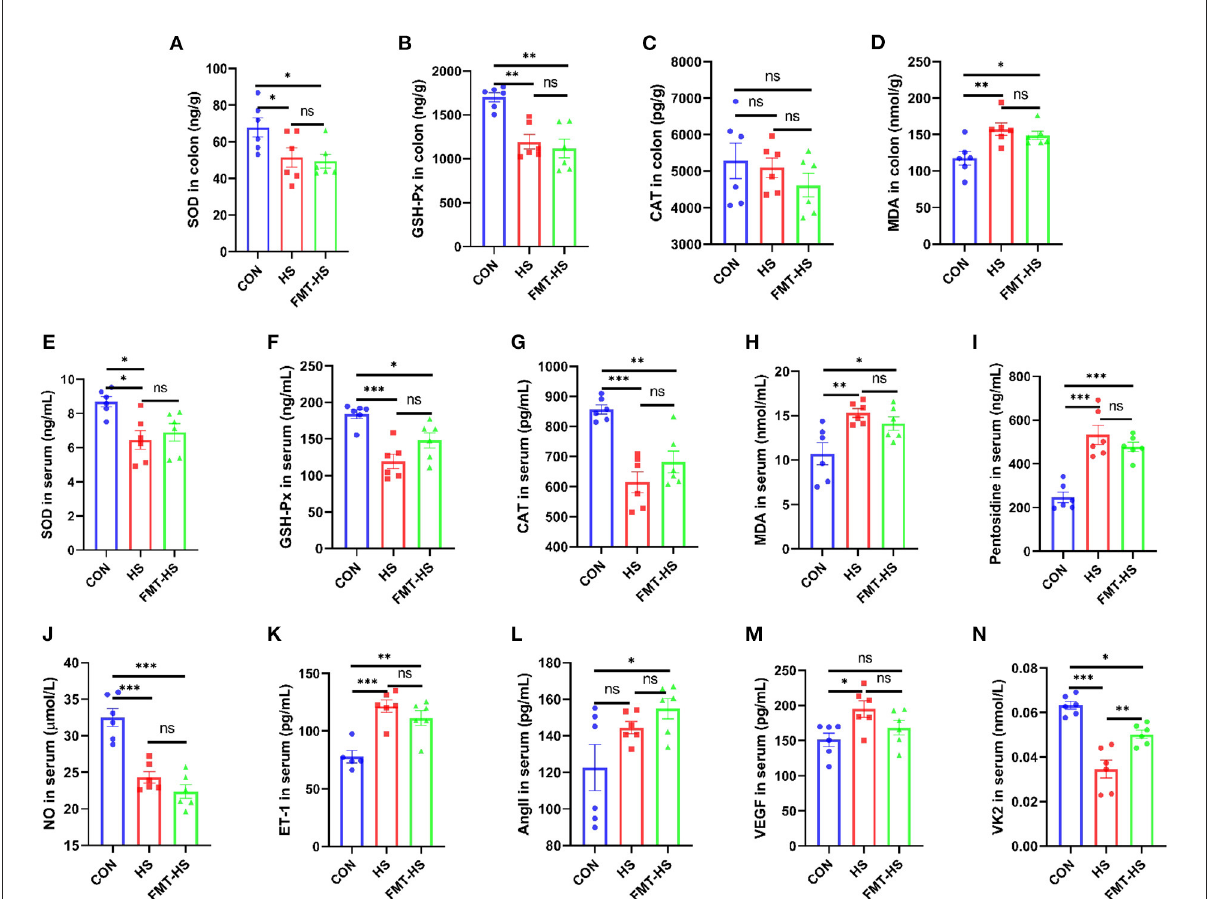
FIGURE1 High salt (HS) induced intestinal aging-related factors imbalance in mice, which was transferable by fecal microbiota transplantation. The changes of aging-related factors in colon and serum (A–I) . The changes of vascular endothelial function-related factors in serum (J–N) . SOD, superoxide dismutase; GSH-Px, glutathione peroxidase; CAT, catalase; MDA, malondialdehyde; NO, nitric oxide; ET-1, endothelin-1; AngII, angiotensinII; VEGF, vascular endothelial growth factor; VK2 vitmain k2, respectively. CON, natural diet; HS, 8% salt diet; FMT-HS, gut microbiota of HS group mice transplanted to CON group mice. All data are expressed as mean ± standard error (SEM). One-way ANOVA with Tukey post hoc test was conducted. * p < 0.05, ** p < 0.01, *** p < 0.001; ns, no